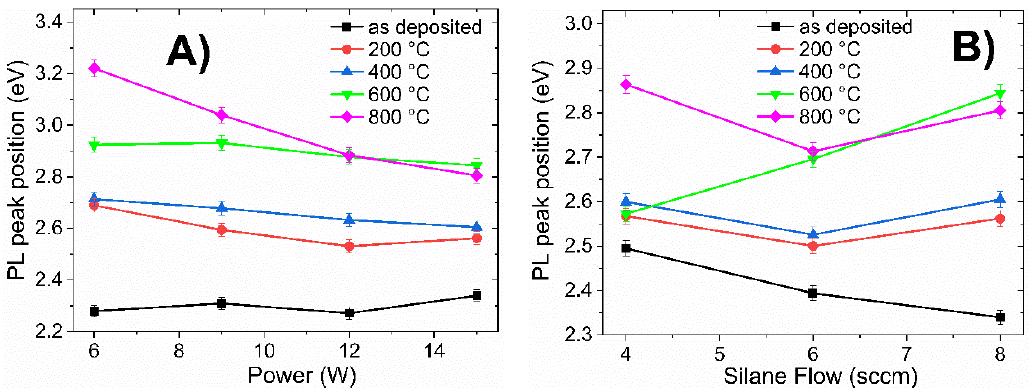
Figure 7. PL peak position of a-Si 1 – x C x :H films deposited: ( A ) with different RF power (6 – 15 W) keeping the ratio R 0 constant (37.5); and ( B ) with different R 0 (37.5 – 75) with constant RF power (15 W).